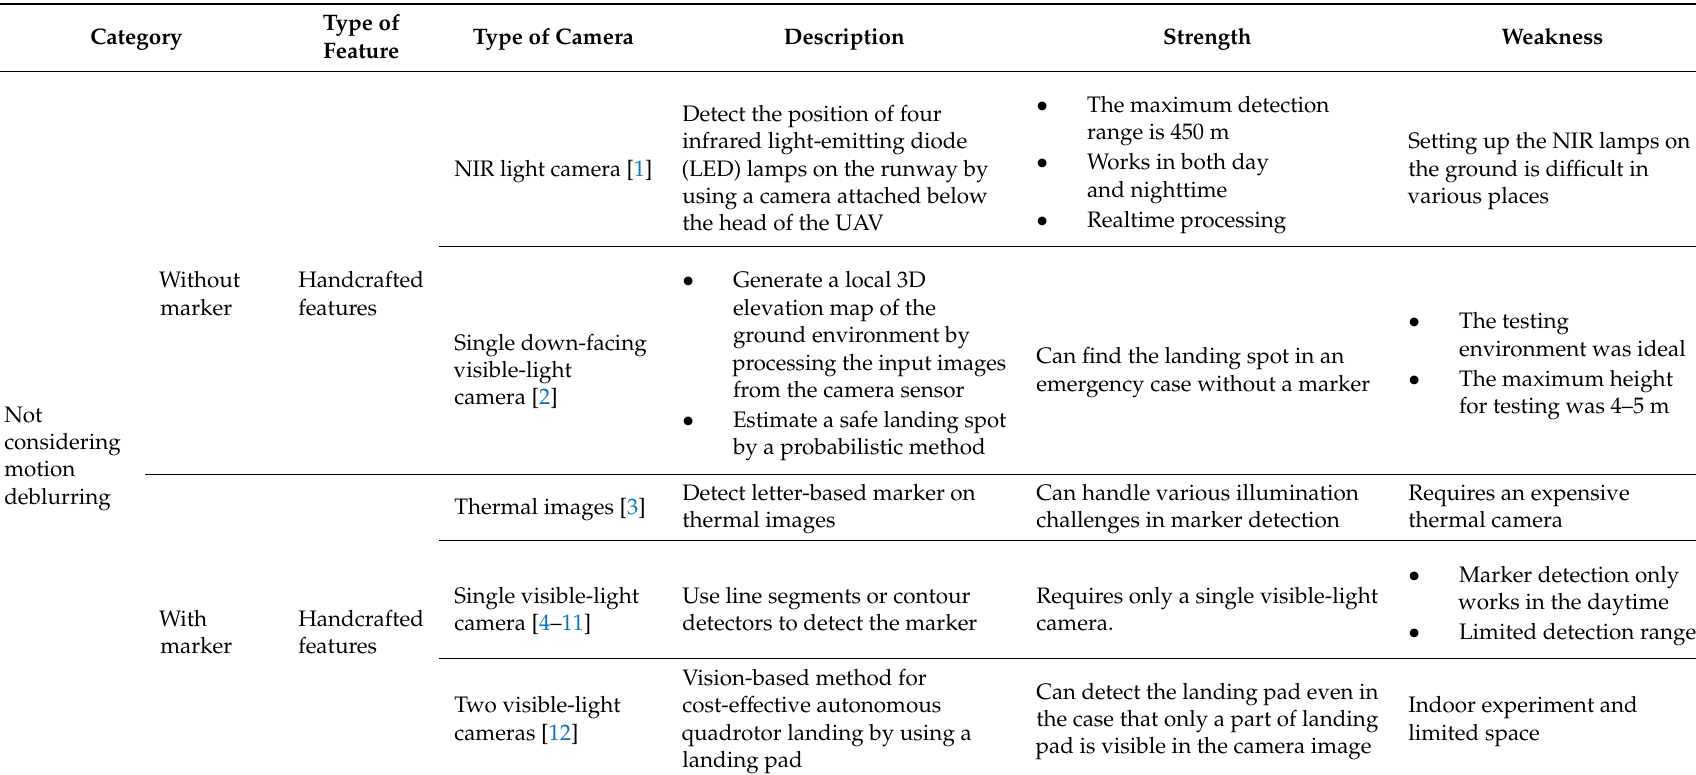
Table 1. Summary of theoretical comparisons between the proposed method and previous studies on vision-based drone